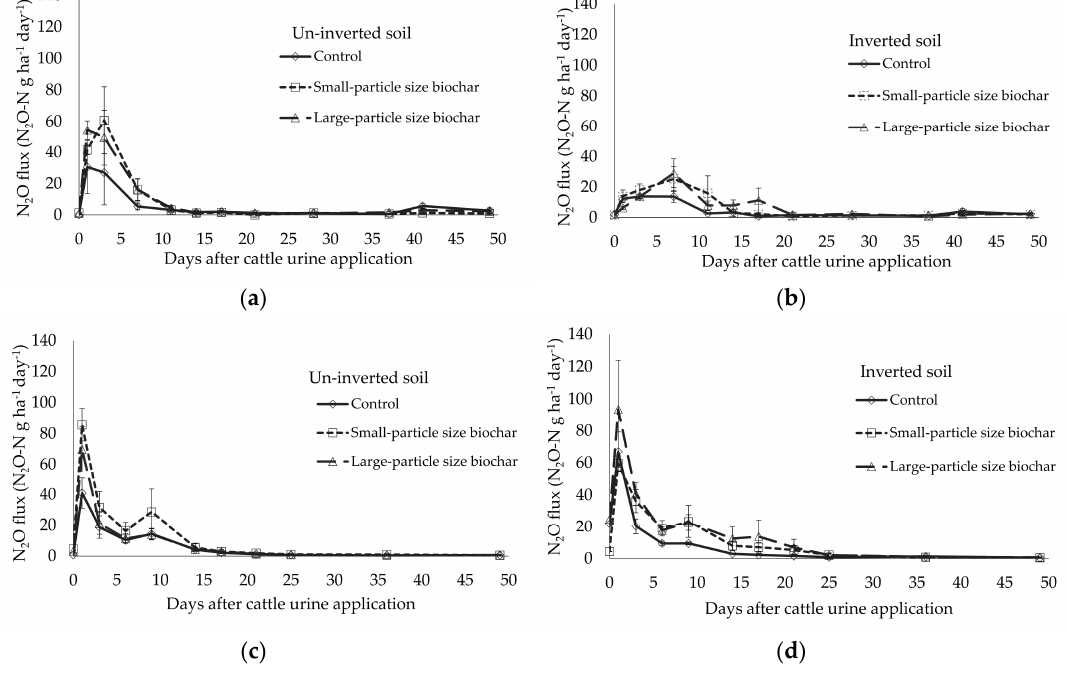
Figure 2. Average N 2 O-fluxes (SEM ( n = 4)) by day from soil columns after cattle urine application for summer ( a , b ), and autumn trials ( c , d ).